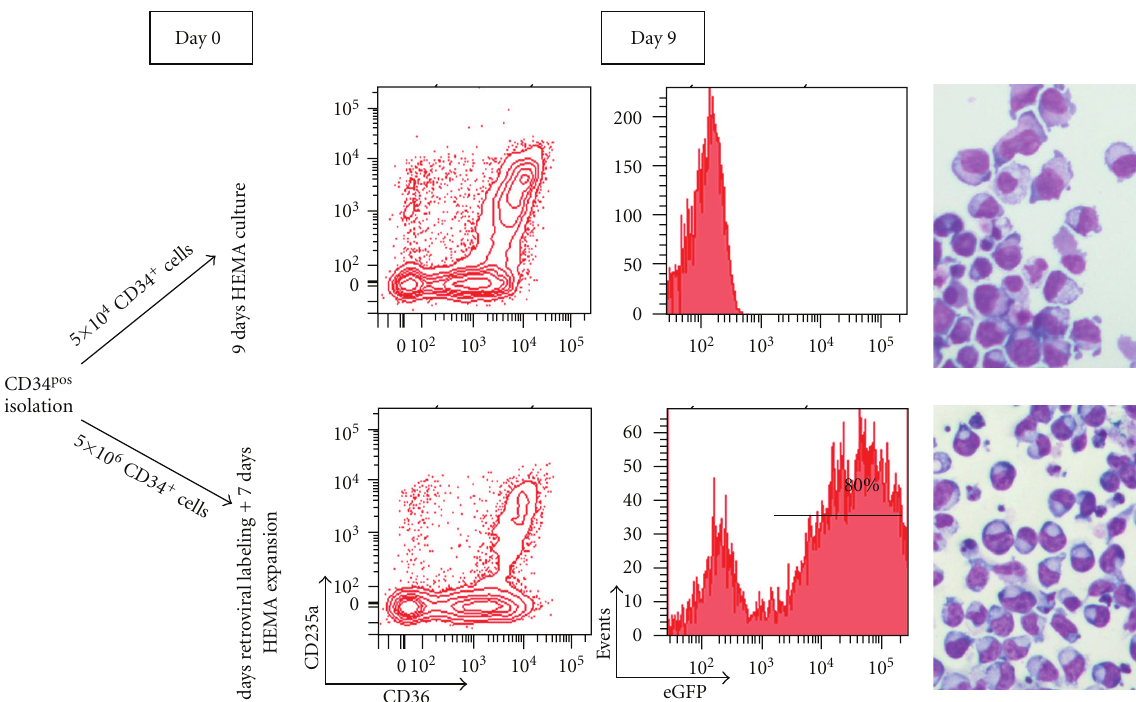
Figure 5: Ex vivo expanded extGLuc + EBs express high level of eGFP by FACS analyses. Maturation profile and transfection e ffi ciency of nontransfected (as control, top panels) and transfected (bottom panels) EBs at day 9 of HEMA culture identified on the basis of CD36/CD235a and eGFP expression (on the left) and on the basis of morphology (May-Grunwald staining, on the right), magnification 40x. The transfected EBs express great levels of eGFP. The transfection did not alter the morphology of the cells but slightly reduced the expression of the CD235a probably due to interference with the GFP signal. At day 9, in transfected and control cultures the fold increase was 48-fold and 325-fold, respectively, and the viability was 98% in both